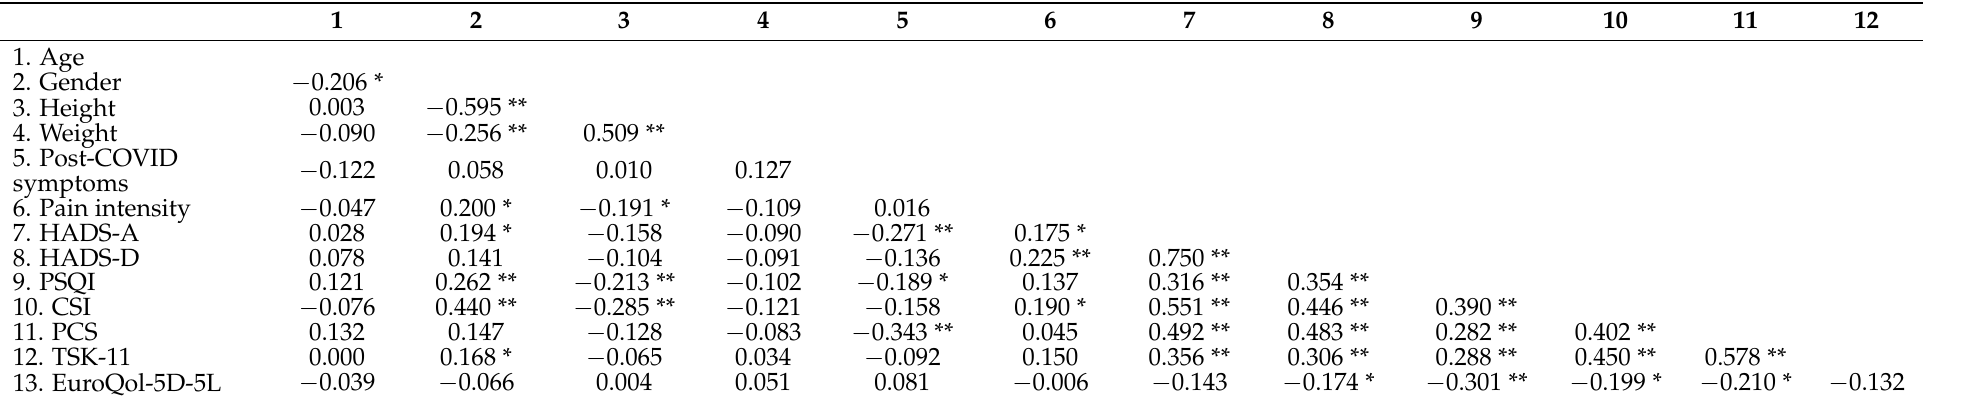
Table 2. Pearson product-moment correlation matrix between sociodemographic, psychological, neuro-physiological, and clinical